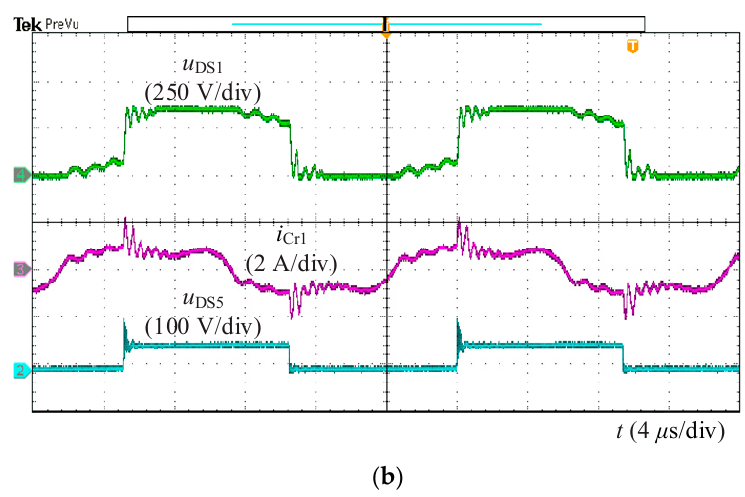
Figure 17. Experimental results with half-bridge configuration at light load condition: ( a ) forward mode, 200 W; ( b ) backward mode, 200 W.